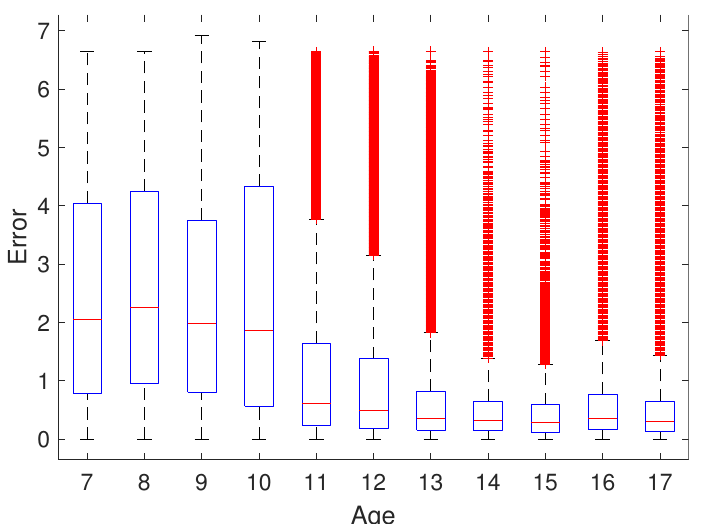
Figure 2. This graph shows the absolute error of the 34496 car positions registered for each participant, by